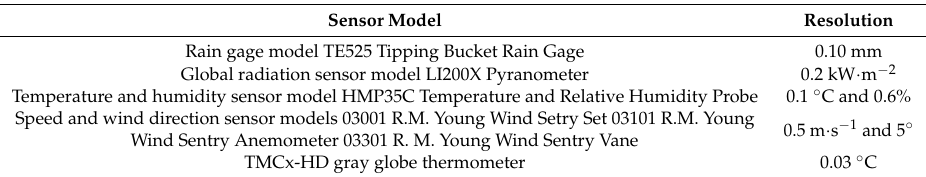
Table 1. Sensor model and resolution.